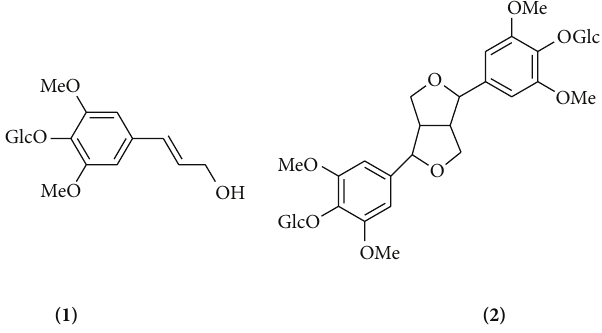
Figure 2: Chemical structures of eleutherosides B ( 1 ) and E ( 2